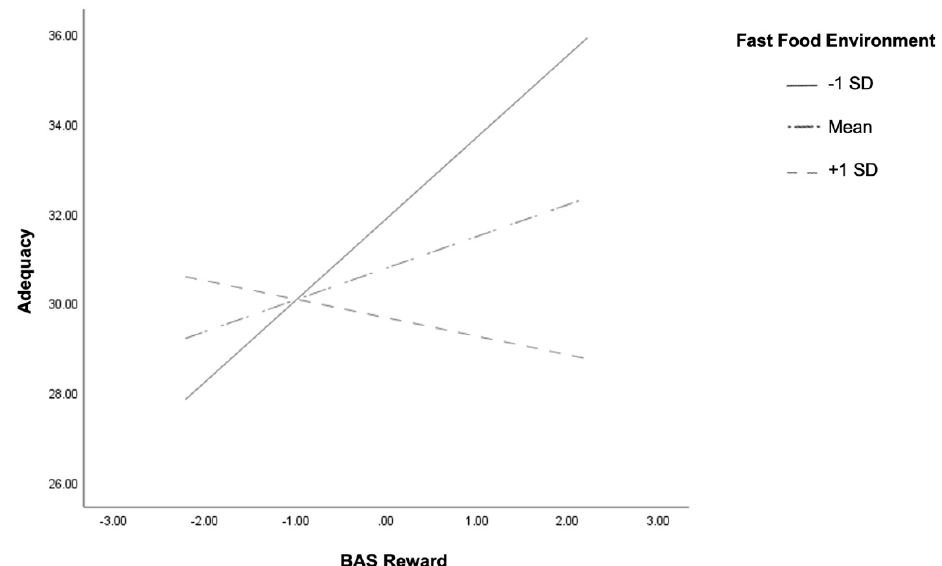
Figure 2. Two-way interaction of BAS reward and fast-food environment in relation to adequacy Healthy Eating Index subscores in early adolescents. High and low levels of the variables are plotted at +1 and − 1 standard deviation from the mean.